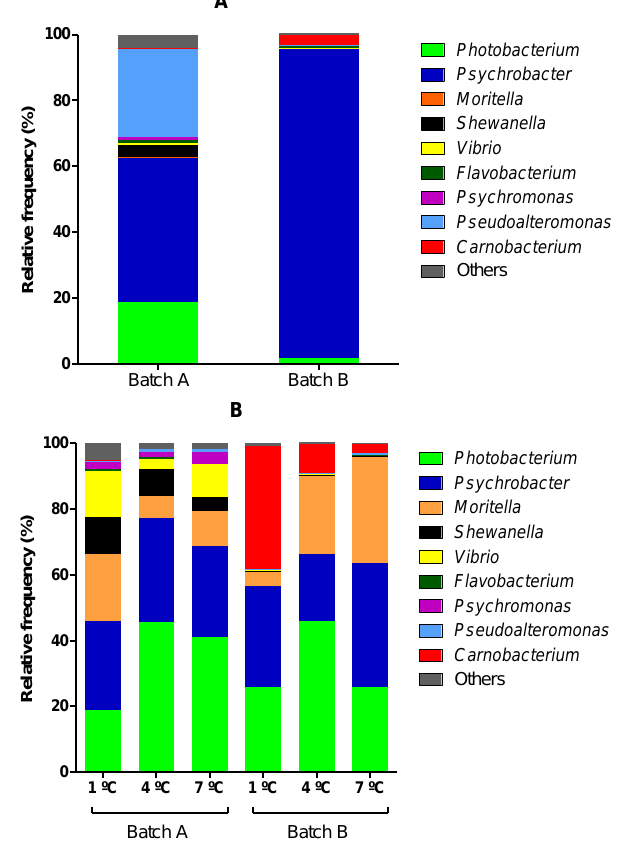
Figure 2. Metagenomic analysis of the composition of the microbiota of hake fillets at day zero ( A ) and at the time of spoilage ( B ) of the two batches studied (Batch A and Batch B) and at each of the storage temperatures investigated (1, 4, and 7 °C).